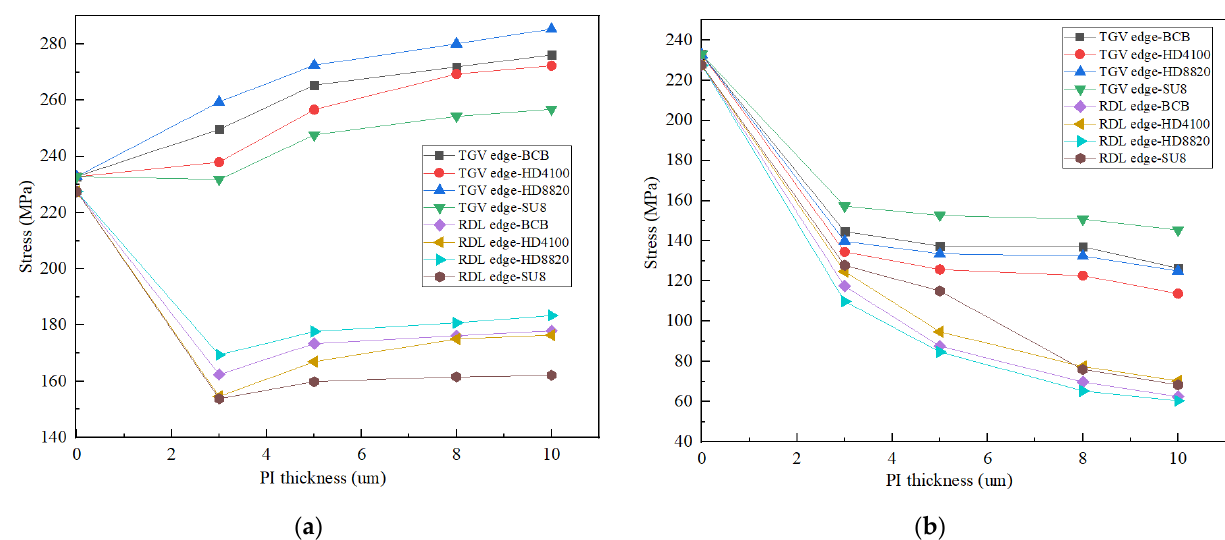
Figure 11. ( a , b ) denote the effect of different PI types and thicknesses on stresses in A and B structure, respectively.